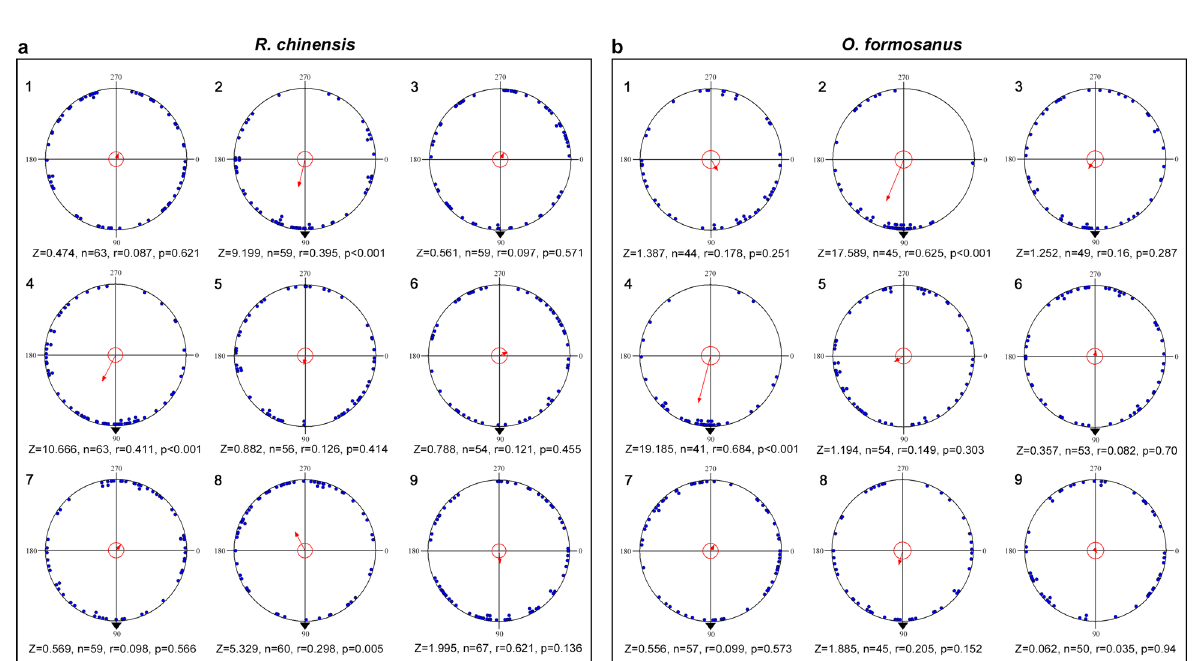
Fig. 6 The comprehensive effects of Orco , Cry 2, the pheromone trail and magnetic fi eld strength on the orientation of R. chinensis and O. formosanus . a Heading directions of R. chinensis in relation to four factors in the orthogonal design. b Heading direction of O. formosanus in relation to four factors in the orthogonal design. Numbers on the upper left corner of each schematic indicate different treatments of four factors in the orthogonal design L9 (3 4 ) (For information about treatment 1-9 of R. chinensis and O. formosanus , see Supplementary Table 8 in Materials and